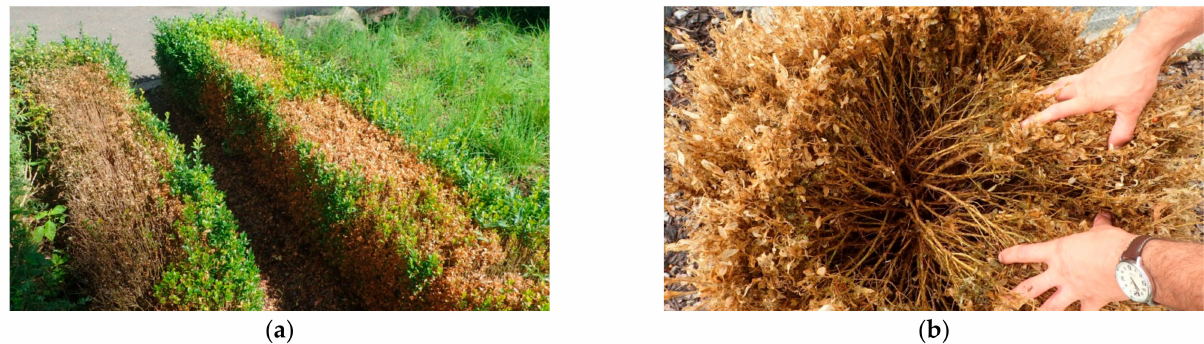
Figure 3. Buxus sempervirens bushes damaged by C. perspectalis : ( a ) an example of a positively verified photograph uploaded to the website “Allotment and Garden Our Passion”; ( b ) an example of verification of a report on the presence of C. perspectalis in the field: Trzebownisko near Rzesz ó